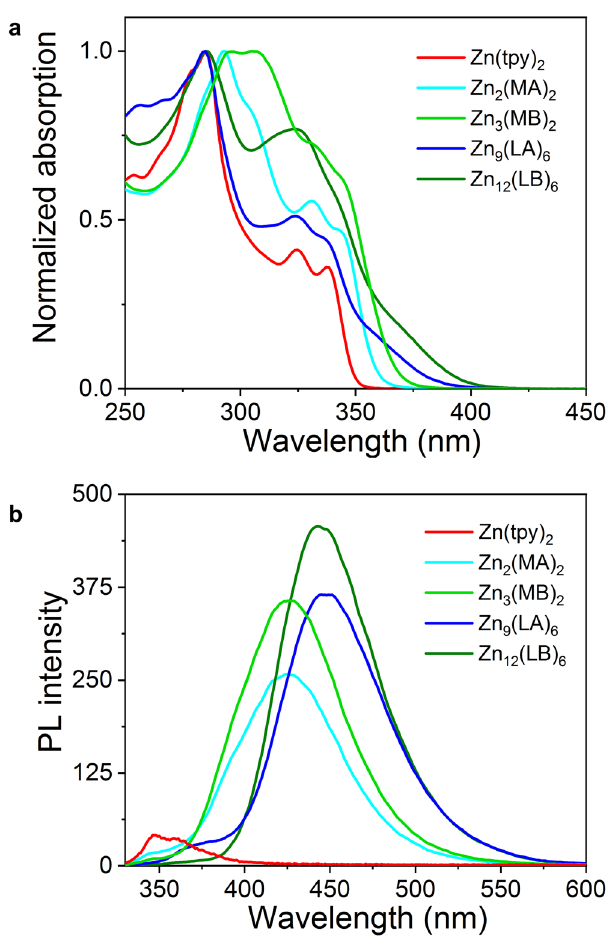
Fig. 8 Photophysical data of the complexes. a Normalized UV/Vis absorption of all complexes in CH 3 CN. b PL spectra of all complexes in CH 3 CN (10 − 6 M, λ e = 325